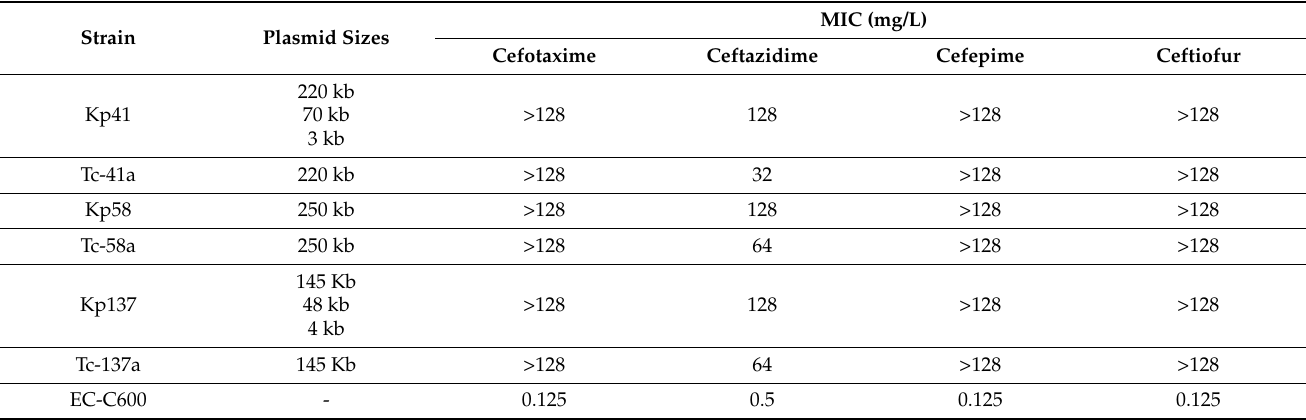
Table 2. Minimum inhibitory concentration and plasmid sizes of CTX-M-15-producing isolates and respective transconjugants.